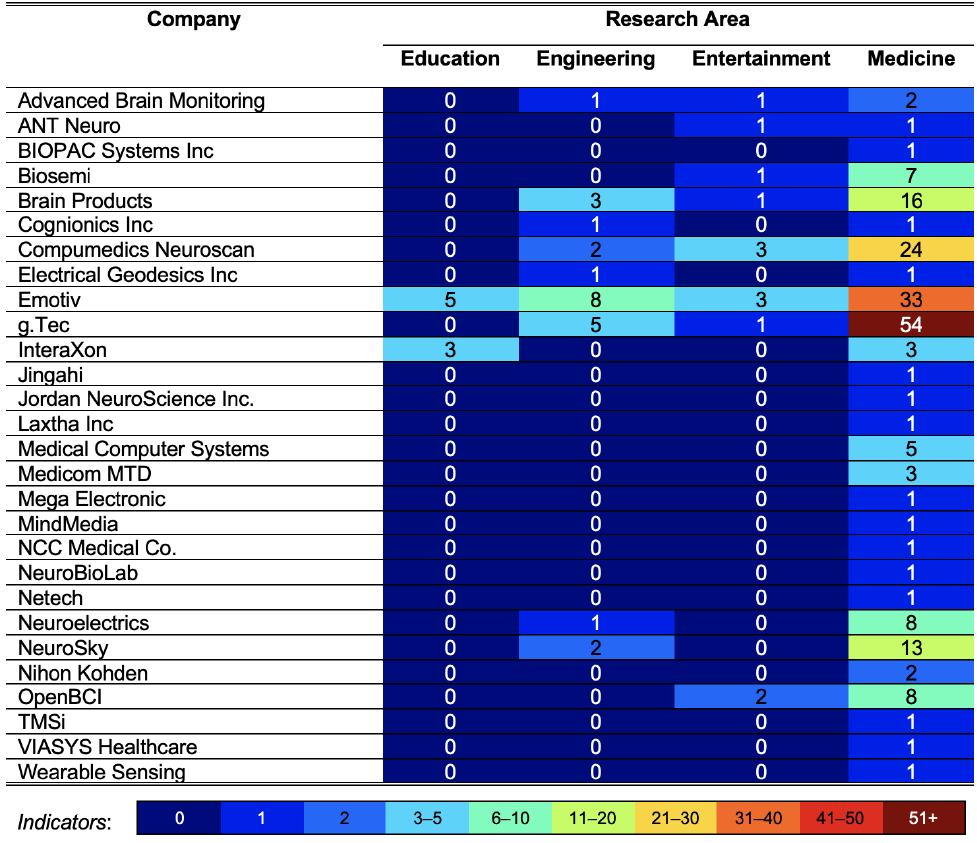
Figure 4. Proportion chart of published article research areas based on noninvasive BCI technology.